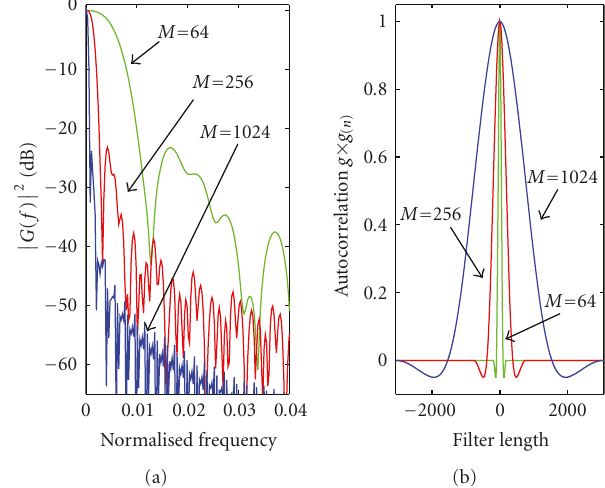
Figure 9: Frequency response and pulse autocorrelation for parameters M 0 = 2, N 0 = 3, and L f = 2 N